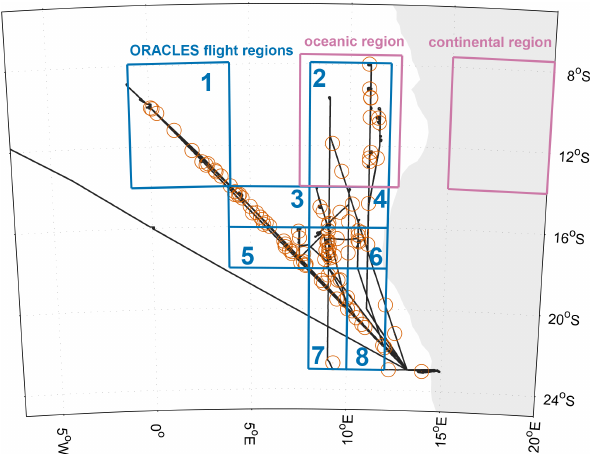
Figure 1. Map showing the flight tracks of the 14 P-3 flights dur- ing ORACLES-2016 (black lines) and the areas of study in this work. Note that the SE-to-NW diagonal (passing through zones 1, 3, 5, 7, and 8) includes six routine flights overlaying one another. Reddish circles indicate locations of the 95 partial or full aircraft vertical profiles during all flights which will be discussed in more detail in Sect. 3.3. The blue boxes indicate the regional subsets (la- beled zones 1–8) used in the spatially subdivided aircraft analysis in Sect. 3, and the lavender boxes show the oceanic and continental regions used for the reanalysis analysis in Sect.